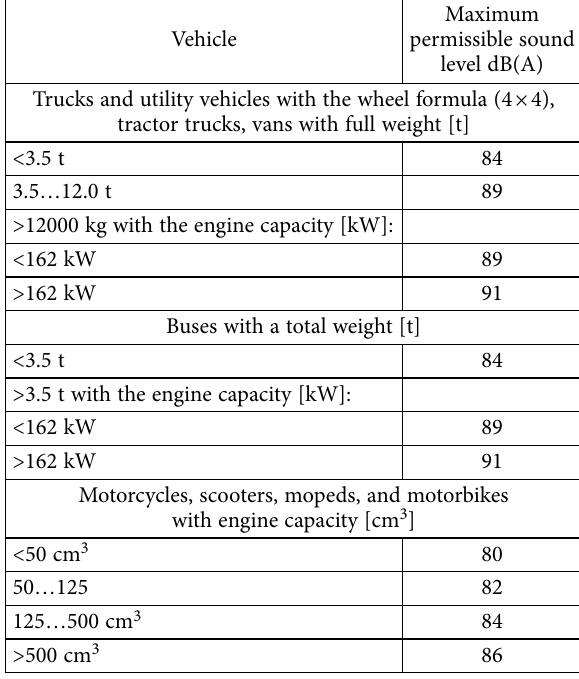
Table 1. Maximum permissible sound levels dB(A) at a distance of 7.5 m from the axis of movement at a speed of 50 km/h Vehicle